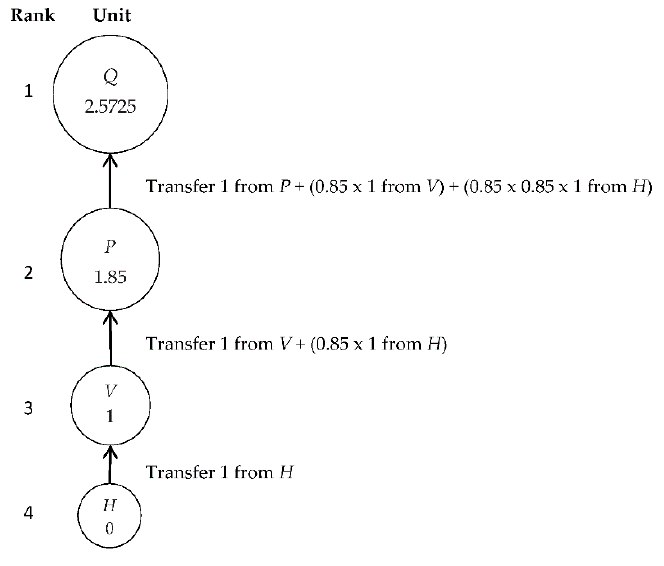
Figure 8. Ranking as a hierarchical link network.